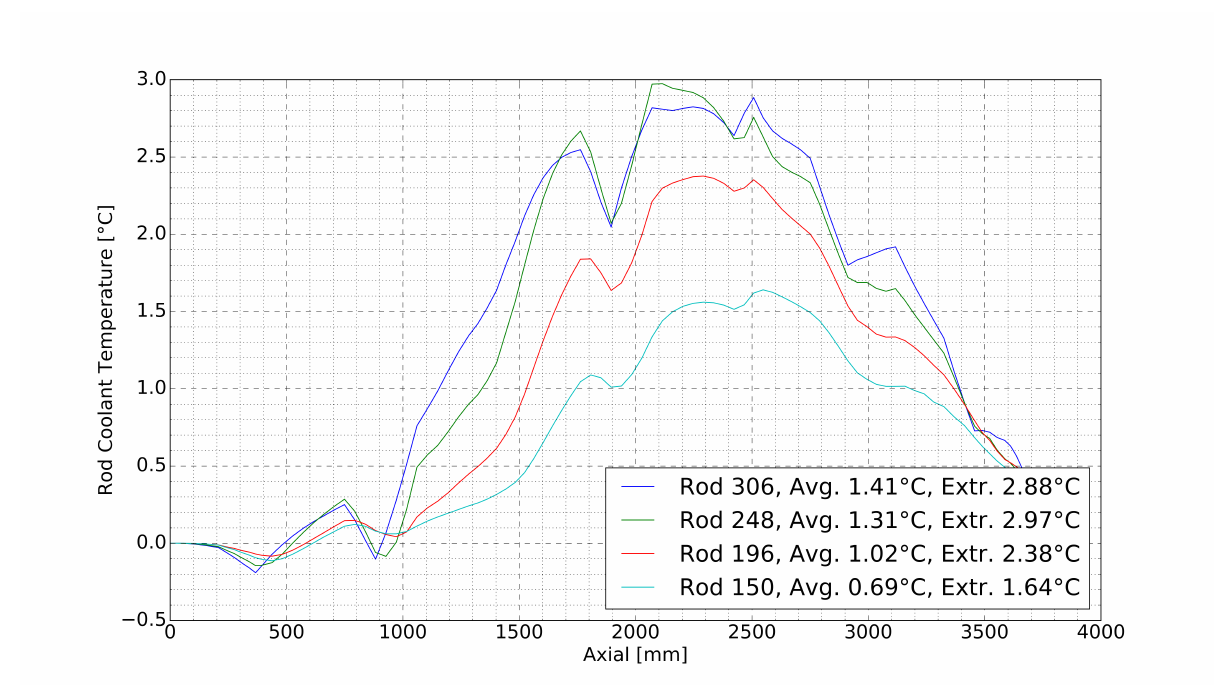
Figure 8. Example of rod coolant temperature differences - FA1.